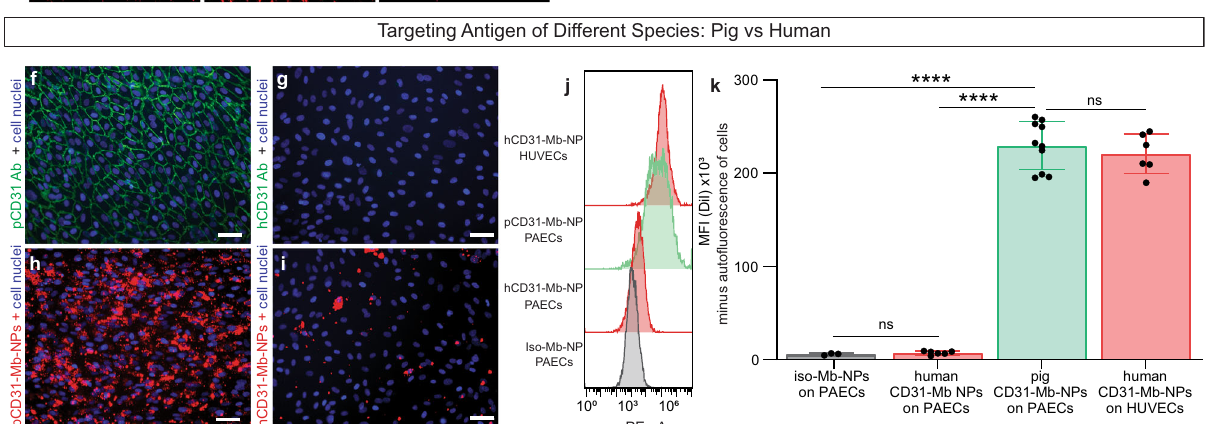
(Ab) ( f ), fl uorescent anti-human-CD31 Ab ( g ), anti-pig-CD31-Ab-Mb-NP ( h ) or anti- human-CD31-Ab-Mb-NP ( i ). Fluorescent antibodies and NP are respectively depic- ted in green and in red. Scale bars are 50 μ m. j Representative fl ow cytometry histograms and k summary data of the averaged MFI of fl uorescent NP bound to PAECs or human umbilical vein endothelial cells (HUVECs) in vitro (error bars represent SD). Each data point represents the averaged MFI from three wells with 10,000 HUVECs captured/well ( n =at least three independent experiments). Sta- tistical signi fi cance is shown between groups with **** p <0.0001, *** p <0.001, ** p <0.01,* p <0.05andnswherenosigni fi cantdifferencewasfoundusingmultiple two-tailed T -tests with a Bonferroni correction. Data are presented as mean values+/ − SD. Source data are provided as a Source Data fi le. Mb monobody, NP nanoparticle, pCD31 anti-pig-CD31 Ab, hCD31 anti-human-CD31 Ab, iso